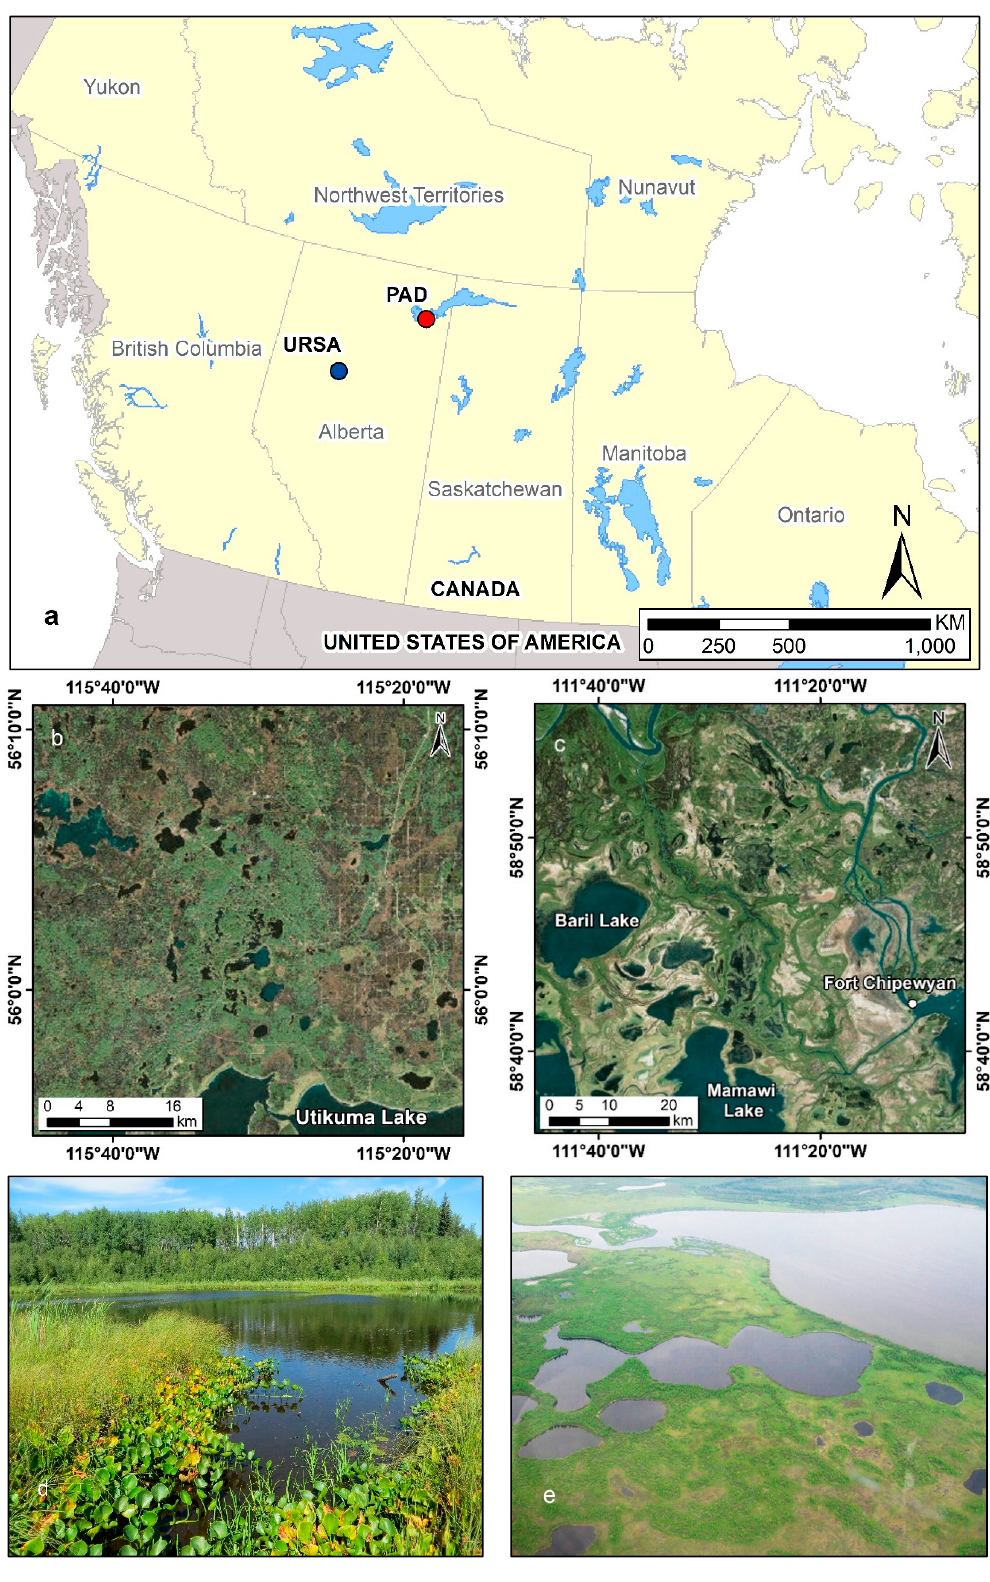
Figure 1. Study site location and study area subsets with field photos: ( a ) the study sites within Alberta, Canada; ( b ) regional location (blue) of the ~20 km × 20 km area of interest (AOI) subset in the Utikuma Regional Study Area (URSA); ( c ) 25 km × 25 km subset (red) of the Peace-Athabasca Delta (PAD) study area; ( d ) vegetation conditions during the growing season for URSA; and ( e ) PAD.